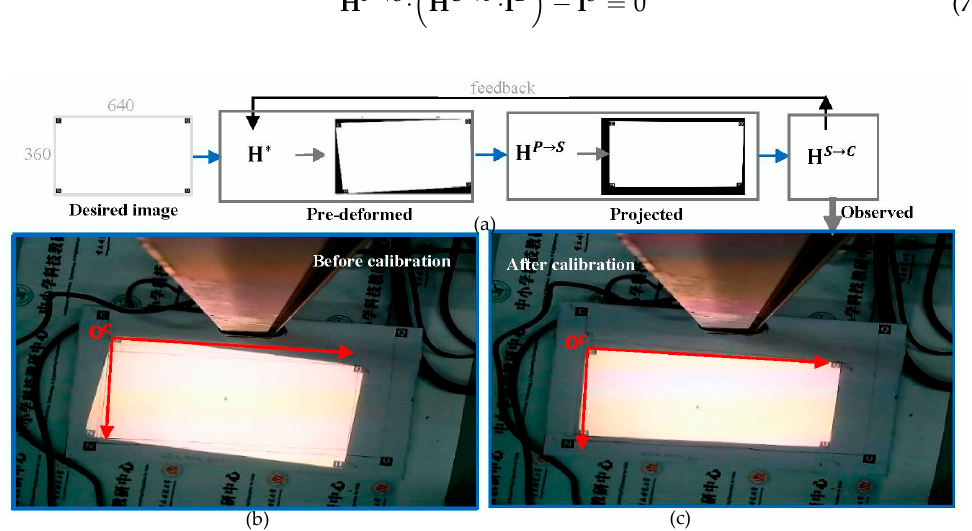
Figure 3. Demonstration of calibrating DLP optical distortion by pre-deforming the desired image, which has a size of 640 × 360 pixels and four letters of “C-Q-N-U” at corners. ( a ) Transform of the desired image through the pre-deformed, projected, and observed blocks; ( b ) the CCD-observed images of DLP projection in the O C coordinate system before calibration, and after calibration ( c